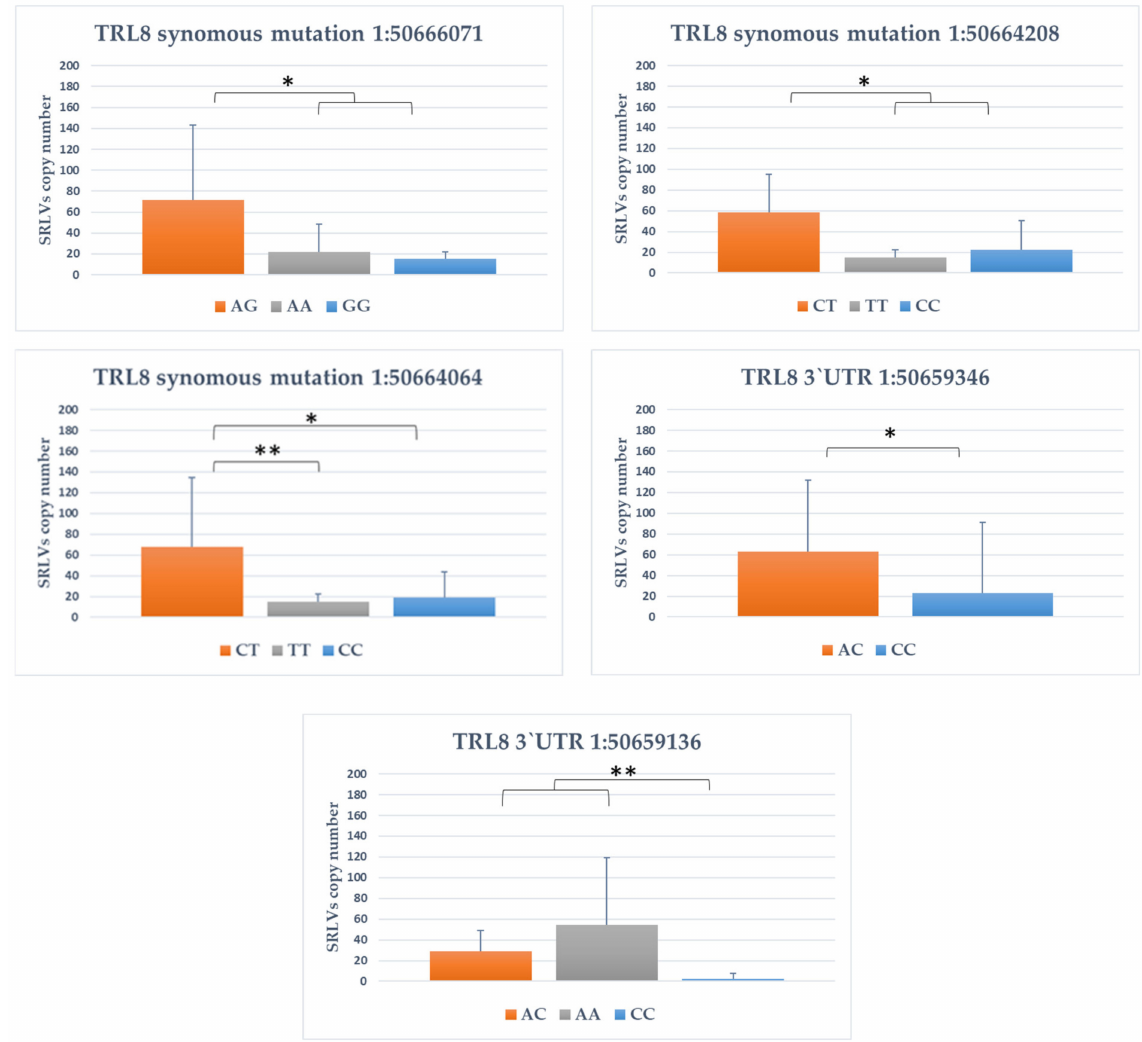
Figure 2. The association between genotype within TLR8 genes and SRLVs copy number. *: p < 0.05; **: p <